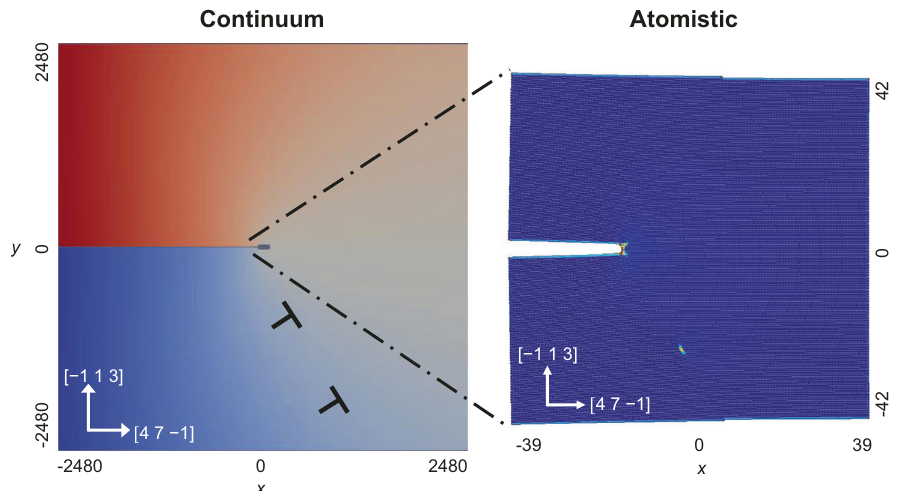
Fig. 5 Multiscale simulation setup. An atomistic domain (right) is embedded in a linear elastic continuum domain (left). Dislocations can move between domains on their corresponding slip planes. The lengths given in this fi gure, which corresponds to the [4 7 − 1]/[ − 1 1 3] crack orientation, are normalized with respect to the magnitude of the Burgers vector, b , and the images are not drawn to scale. The continuum coloring represents the macroscopic displacement in the y direction and the atomistic coloring corresponds to the potential energy of the atoms, highlighting an edge dislocation that has been emitted from the crack tip.